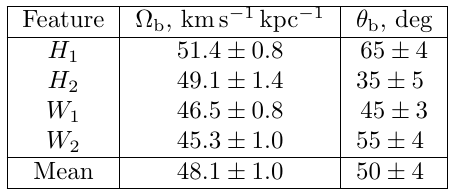
Table 1. Parameters found from the H1, H2 and W1, W2